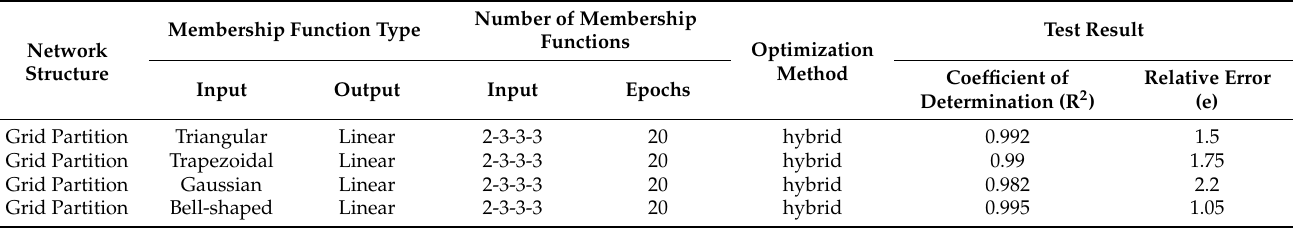
Table 4. Specifications and evaluation results of adaptive fuzzy-neural inference system models